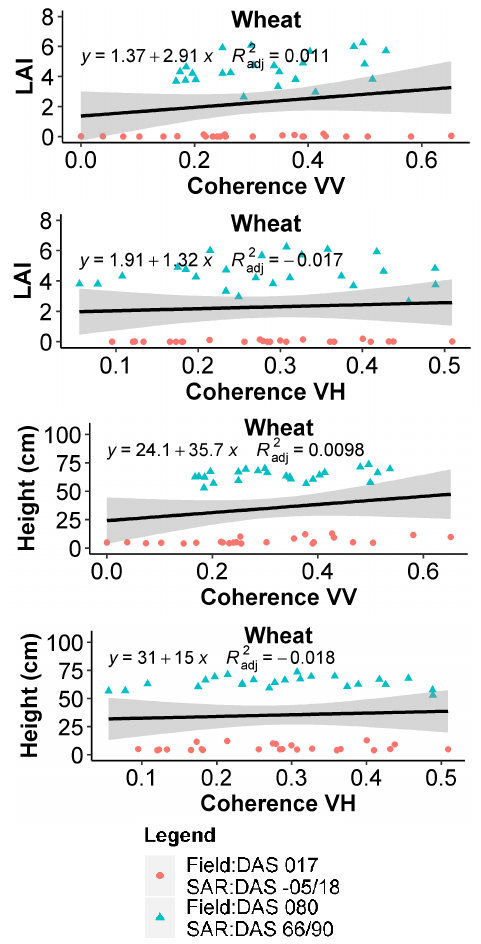
Figure 11. Relationship between biophysical and coherence for wheat